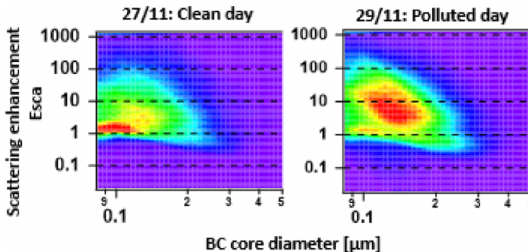
Figure 5. BC particles physical properties on a clean and a polluted day. Scattering enhancement measured using the method discussed by Liu et al. (2019). When the particle number density (colour) is > 70% of the maxima in each panel, then the colour is set to red.